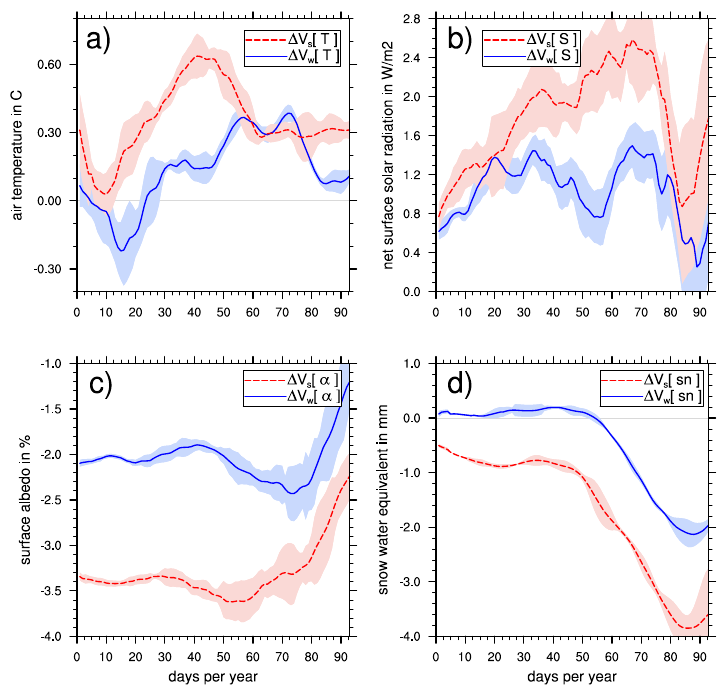
Fig. 4. Spring cycle of the simulations with weak snow masking ( V w =blue line) and strong snow masking ( V s =red, dashed line) averaged over the land area north of 60 ◦ N for the following climate variables: (a) air-temperature in ◦ C, (b) net surface solar radiation in Wm − 2 , (c) surface albedo, and (d) snow water equivalent in mm. The shaded areas indicate one standard deviation around the mean over 240 years. The time series are adjusted to the astronomical dates and smoothed by a 10-day running mean.